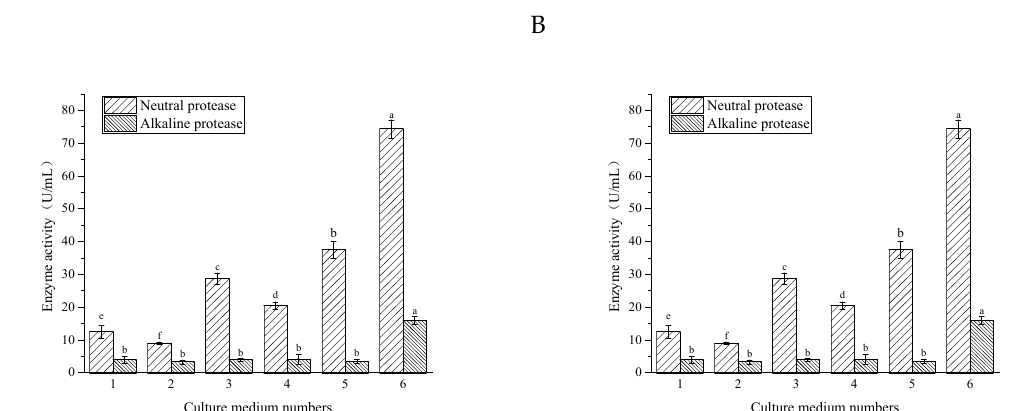
Figure 3. Enzyme activity ( A ), biomass, and pH ( B ) after inoculation with six mediums. The numbers represent different cultural mediums. 1: Beef extract-peptone medium; 2: Nutrient broth medium; 3: LB medium; 4: Typtone soybean medium; 5: Peptone yeast extract glucose medium; 6: YG medium. Bars with different letters differ significantly ( p < 0.05).